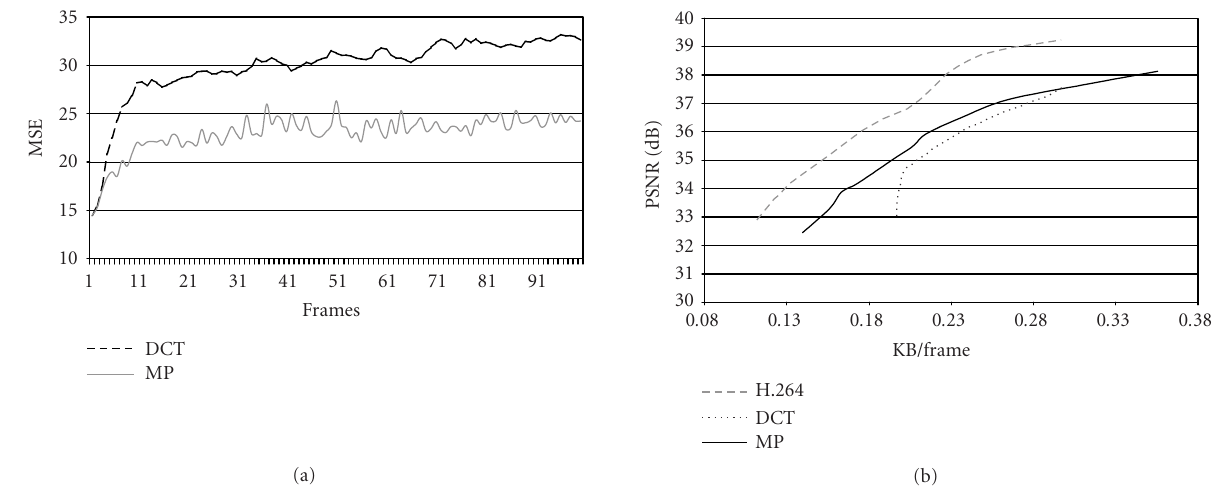
Figure 6: (a) MSE obtained by coding the first 100 frames of Container using MP (0 . 190 KB/frame) and the 8 × 8 DCT (0 . 194 KB/frame); no I-frames. (b) RD curves obtained by coding the first 100 frames of Tra ffi c using 8 × 8 DCT and MP with the same motion estimation and H.264; I-frames